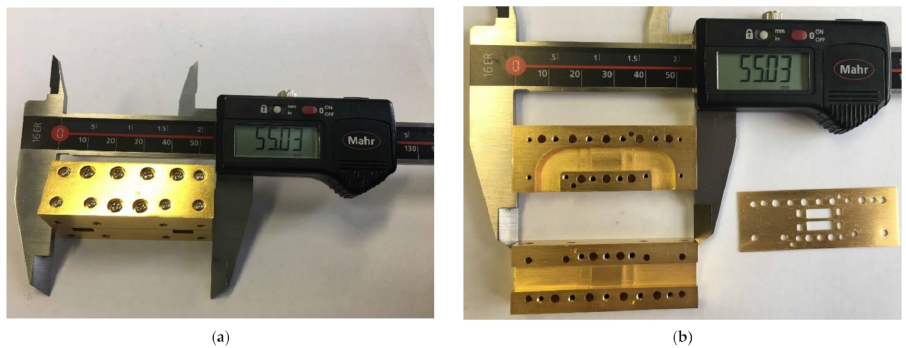
Figure 6. Photograph of sample coupler ( a ) assembled and ( b ) disassembled (the dimensions of sample coupler are 55.03 × 20.02 × 25.02 mm 3 ).